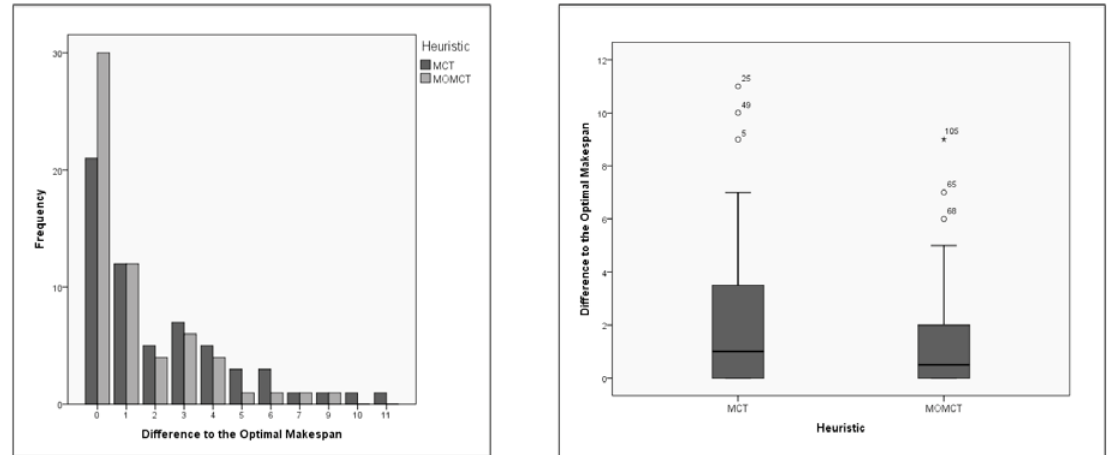
Fig. 6. Bar chart of the solutions of MCT and MOMCT Fig. 7. Boxplot of the solutions of MCT and